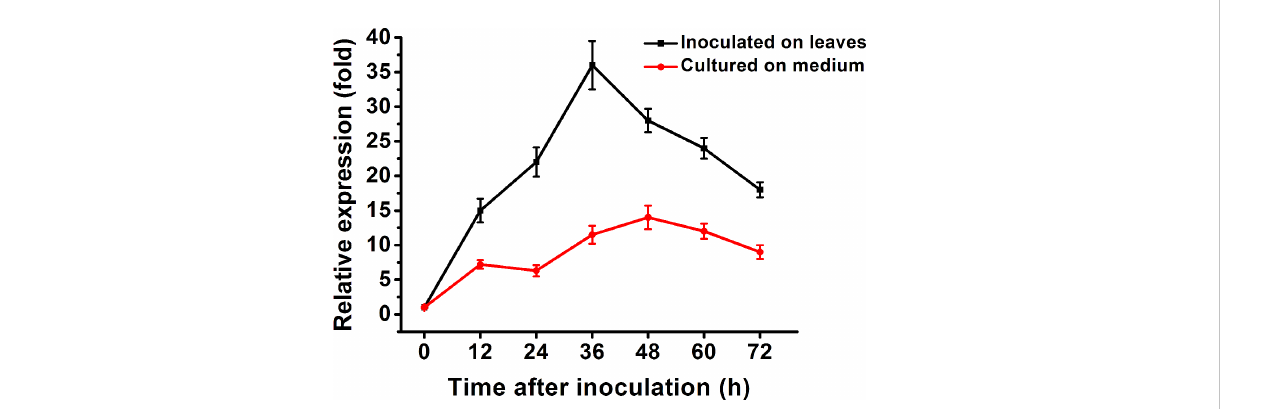
FIGURE 4 Expression of the Bccdi1 gene is upregulated during infection. Bean leaves (black line) or Gamborg ’ s B5 medium (red line) was inoculated with Botrytis cinerea conidia, and the expression level of the Bccdi1 gene was evaluated by RT-qPCR. The expression level of Bccdi1 inoculated on the plant or in Gamborg ’ s B5 medium at 0 h was set as 1, and the relative transcript level was calculated using the comparative Ct method. The transcript levels of the B cinerea bcgpdh gene were used to normalize different samples. Data represent means and standard deviations of three independent